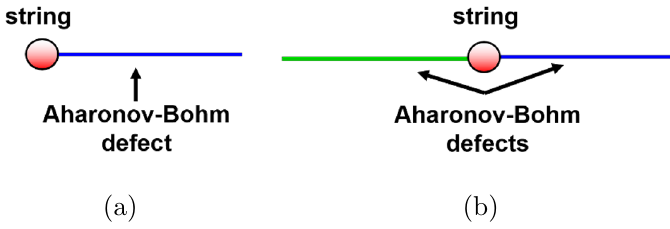
Figure 3 . Aharonov-Bohm defects attached to a string. (a) one or (b) two AB defect(s) attached to cancel the nontrivial AB phase(s) of the doublet fields around the string. (a) is the case of an Alice string. (b) corresponds to the case of an ANO string or Z 2 string. The two AB defects are generated in the two components of the doublet field, and in general they have different tension depending on the VEV of each